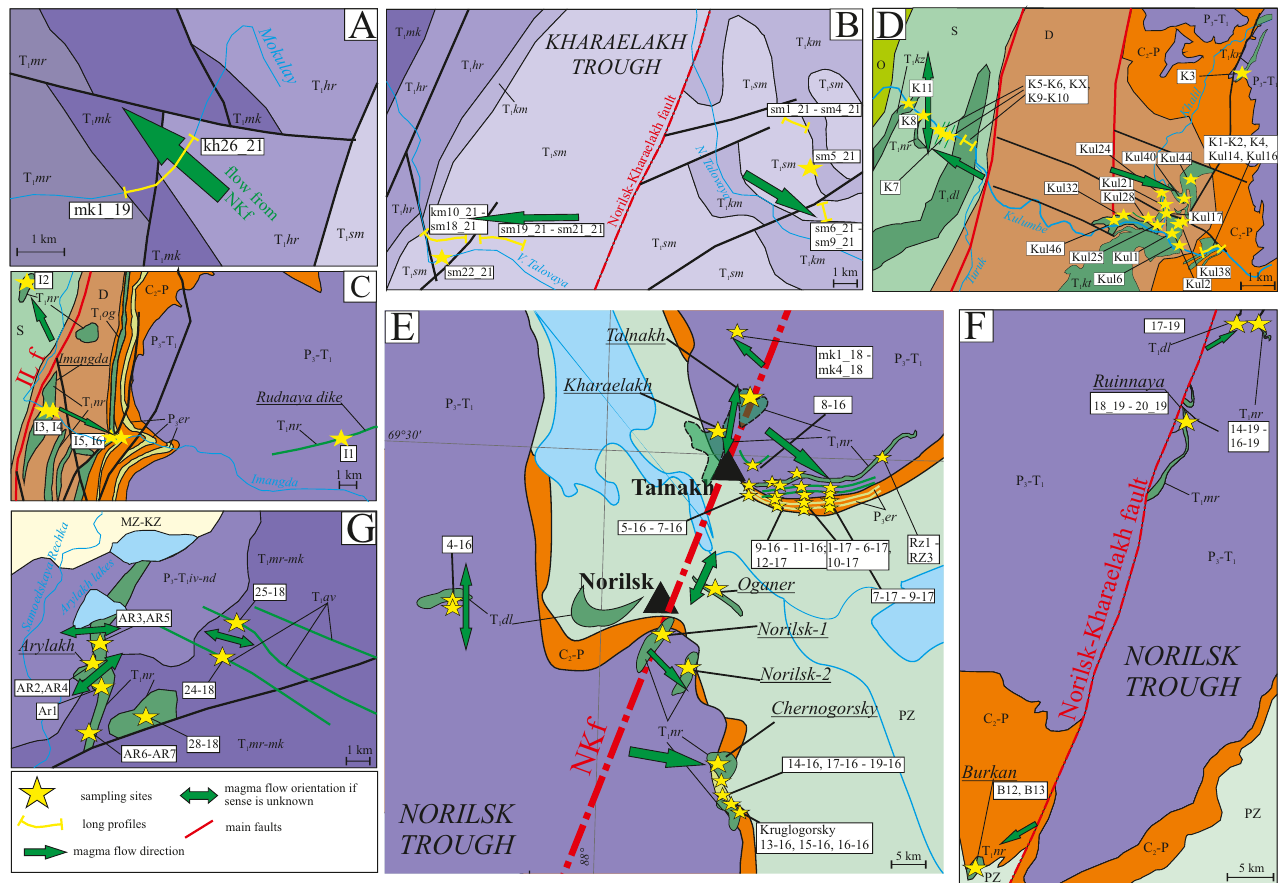
Figure 9. Main directions of magma transport for the studied regions. ( A ) Mokulay; ( B )